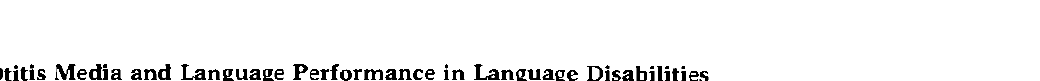
Table 2: Summarized overview of the subtests of the CELF |Wiig, E. and Semel, E., 1980)